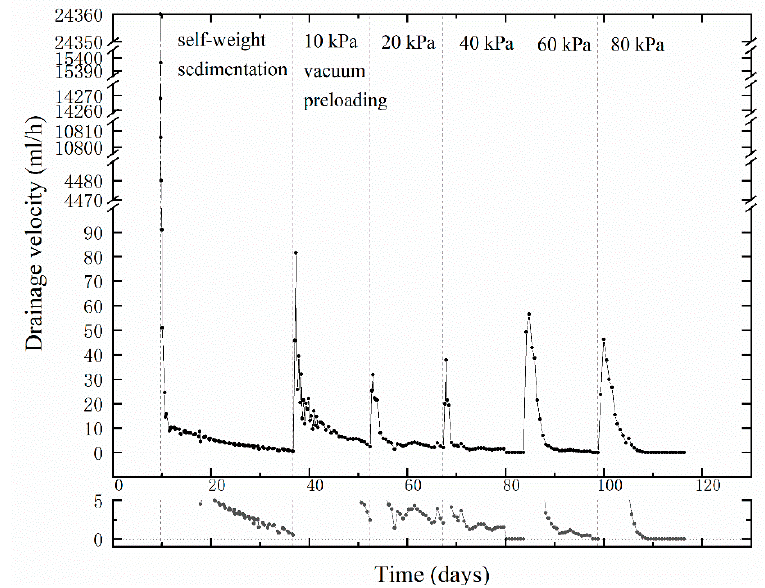
Figure 6. Time-dependent curve of drainage rate in the different stages of treatment.